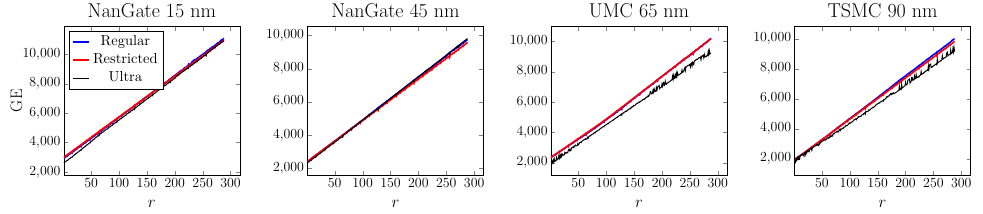
Figure 3: Trivium area measurements (Gate Equivalent) for the three synthesis settings for all unrolling factors r and cell libraries. Note that the number of clock cycles that are required in order to encrypt x bits of data is given by d 1152 of 1.28 MBit of data for r = 288 has a latency of 4449